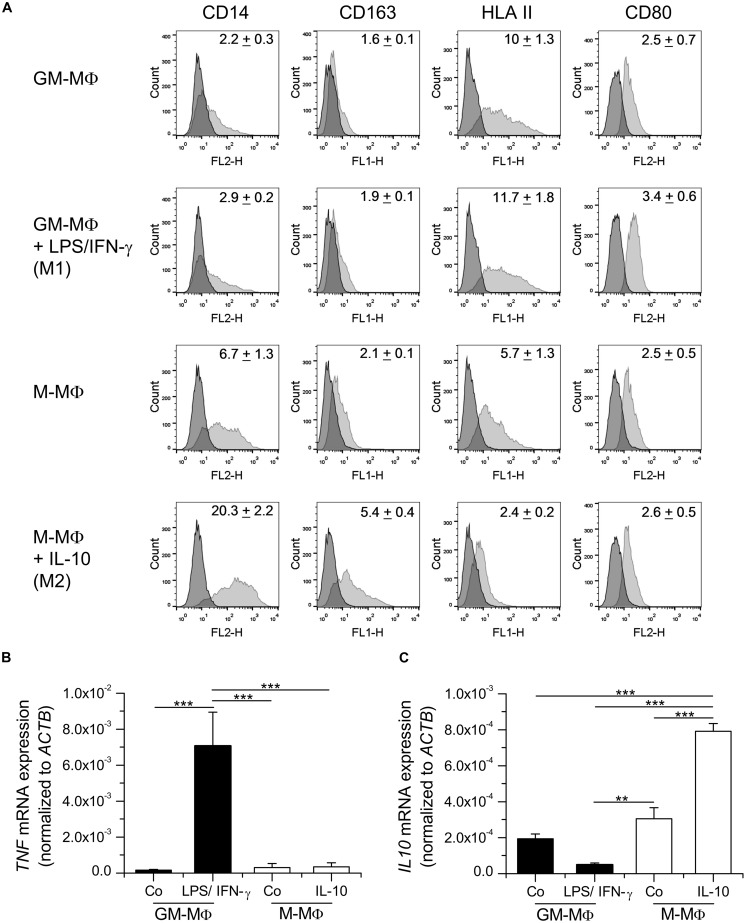
Characterization of in vitro polarized macrophages. (A) Monocyte-derived macrophages (MDM) were either differentiated with GM-CSF (GM-MΦ) or M-CSF (M-MΦ) and treated with LPS and IFN-γ (M1) or IL-10 (M2), respectively. (A) Surface expression of CD14, CD163, HLAII, and CD80 was analyzed by flow cytometry. Dark gray: isotype control; light gray: specific staining. One representative histogram is shown. Geometric mean of fluorescence intensity (GMFI) values are given within graphs and represent the means ± SEM obtained from three independent experiments with cells originating from different donors. (B,C) GM-MΦ and M-MΦ were left untreated or treated with LPS/IFN-γ for 4 h or IL-10 for 16 h as indicated. RNA was isolated and the expression of TNF
(B) and IL10
(C) mRNA was quantified by real-time RT-PCR and normalized to ACTB. Data show means + SEM of independent experiments performed in duplicate with cells from three different donors. p-values were generated by one way ANOVA with Bonferroni’s post hoc test. **p < 0.01, ***p < 0.001.